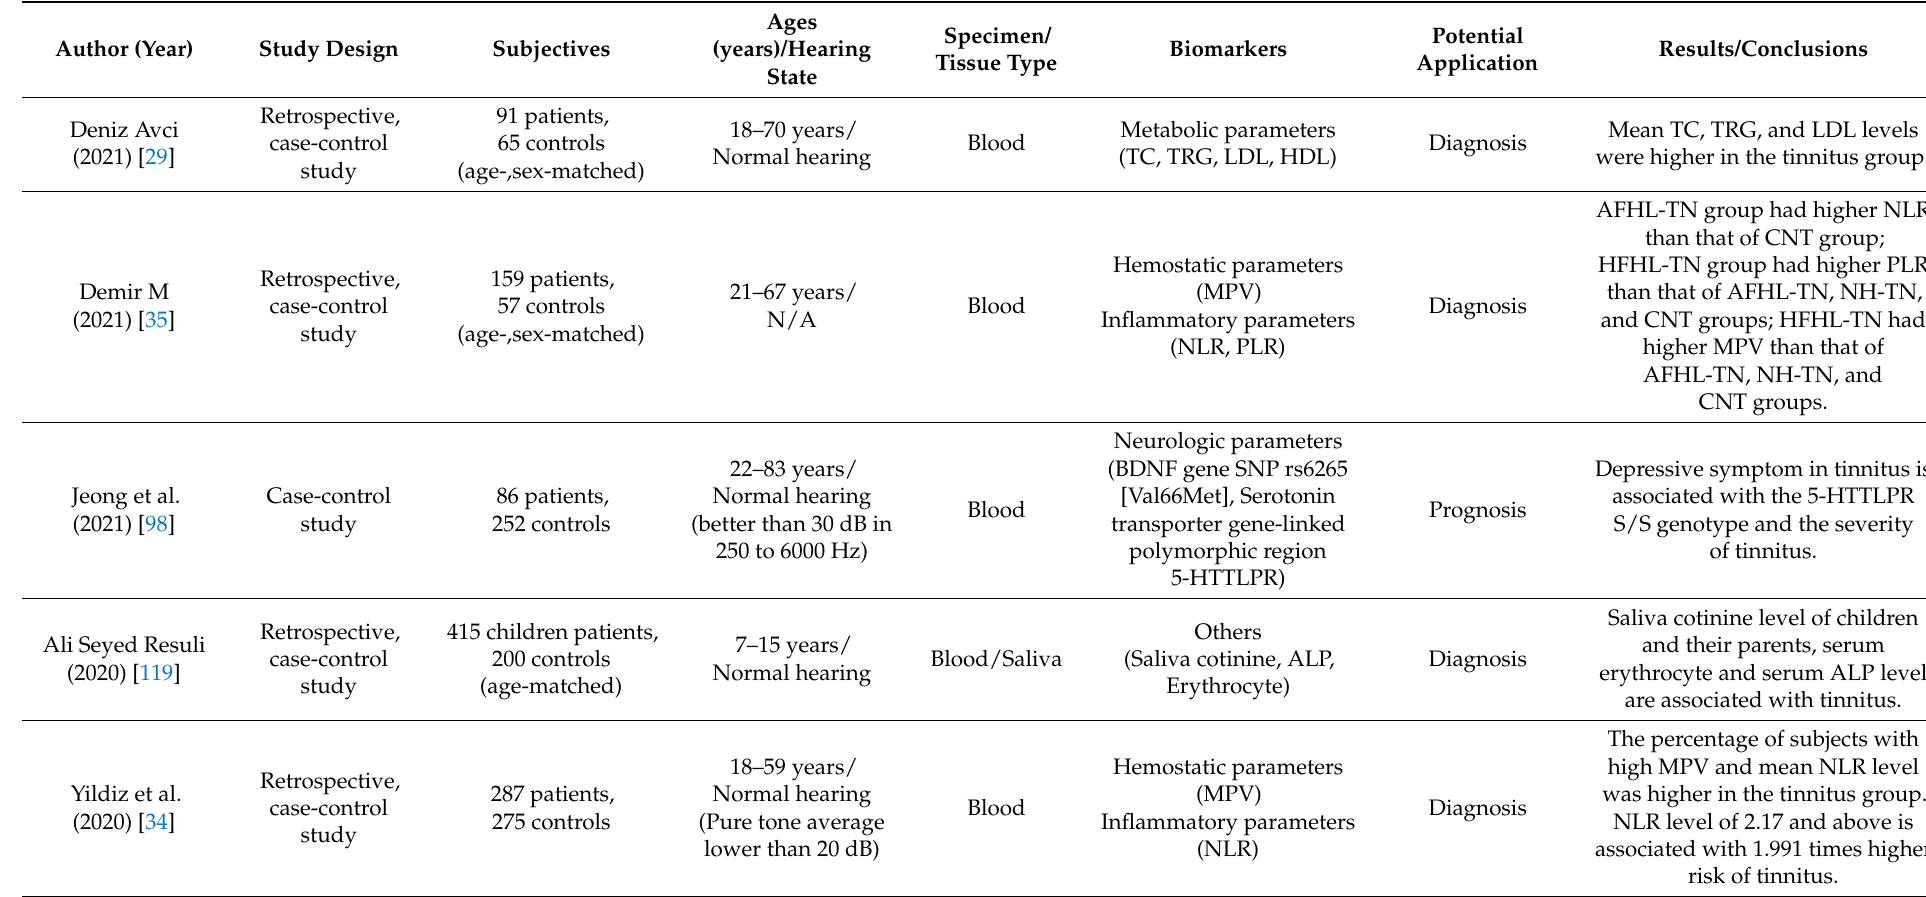
Table 2. Summary of biomarkers for chronic subjective